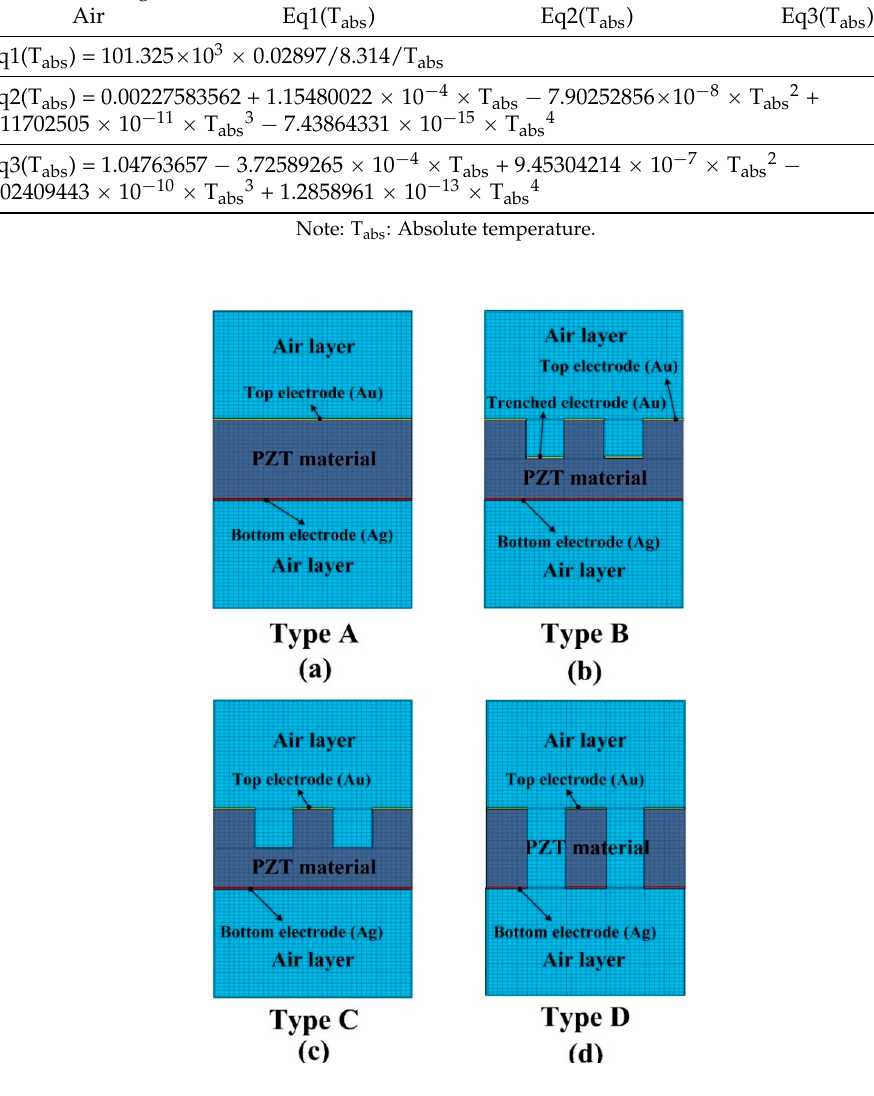
Figure 3. Finite element model for the PZT pyroelectric cells with various structures. ( a ) Type A; ( b ) Type B; ( c ) Type C; ( d ) Type D.